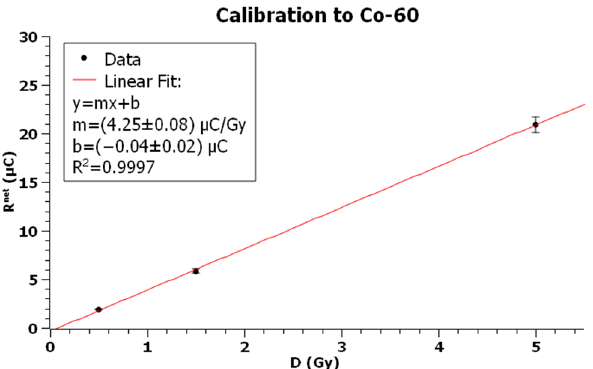
Figure 8. Plot of TLD net readings vs dose for exposures with Co-60. Error bars represent the expanded uncertainty ( k = 2) for Co-60 calibration from Table 4. Table 4. Relative uncertainty analysis for TLD calibration to 250 kV X-rays, with 1 mm Cu added filtration, to Cs-137 and to